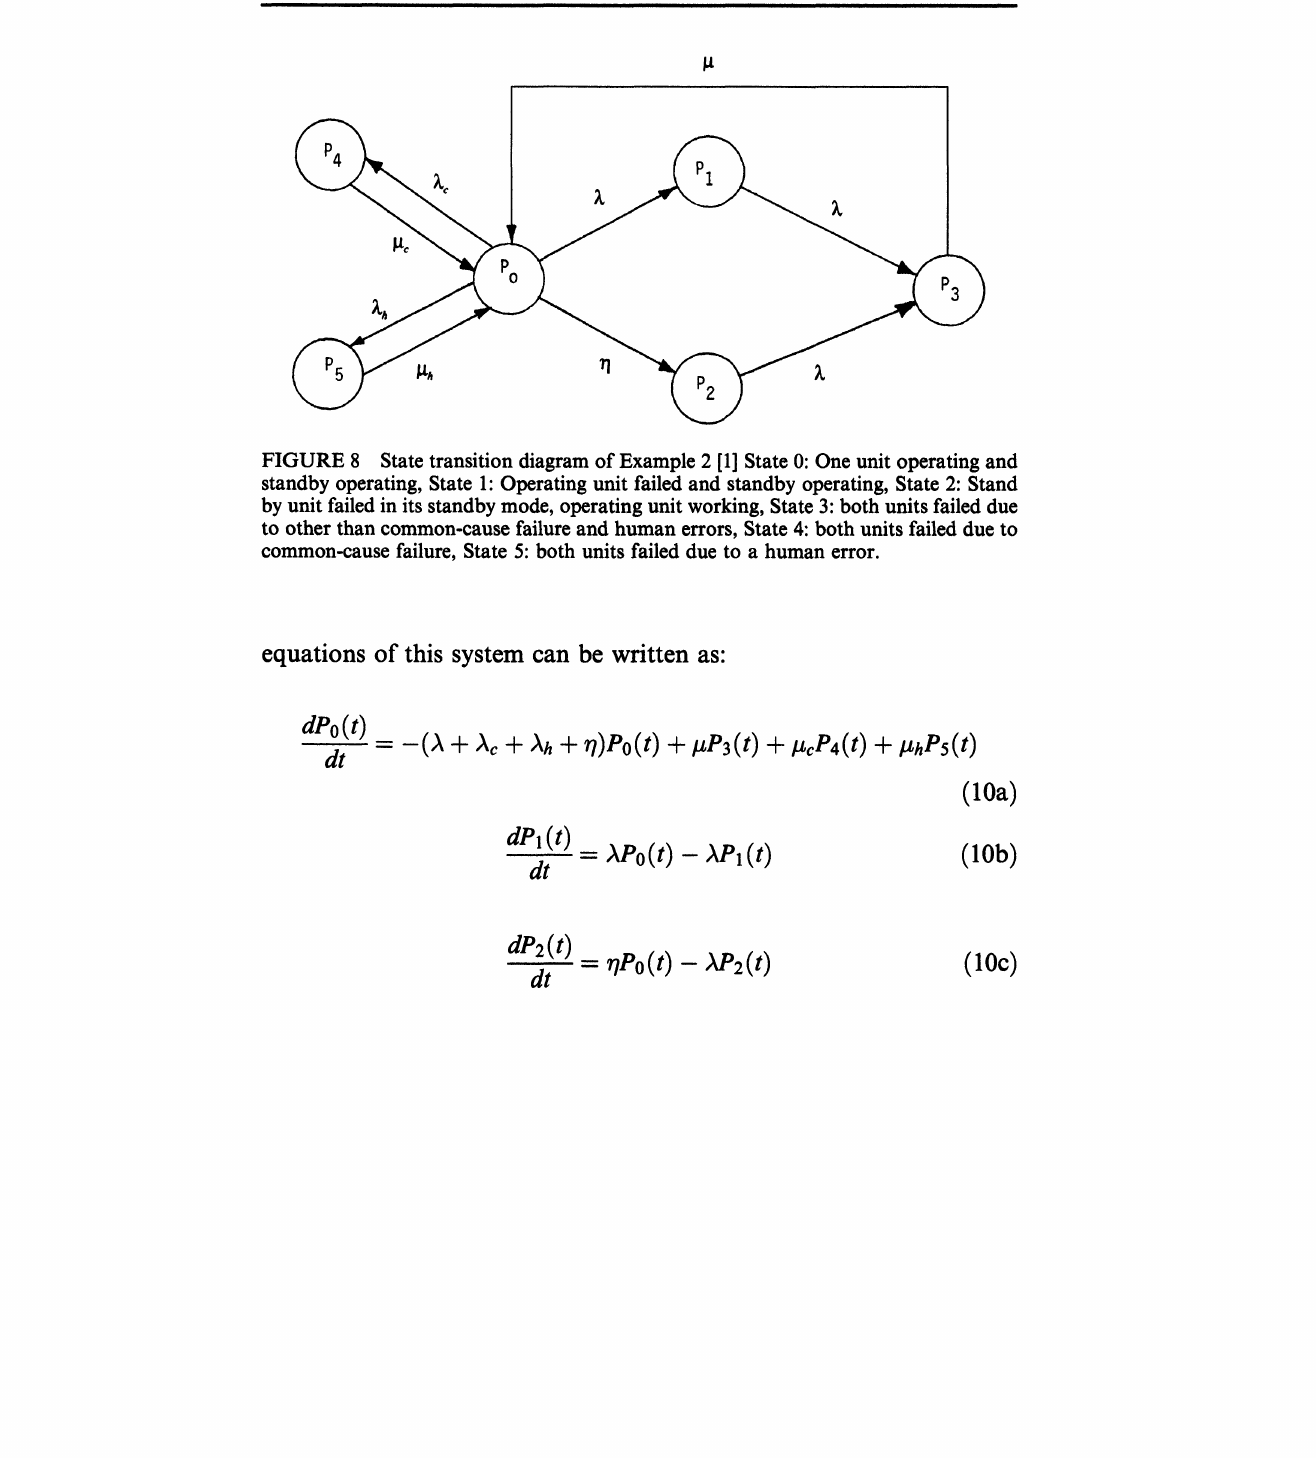
TABLE III Steady-state system availability ofModel III of Example with Aa